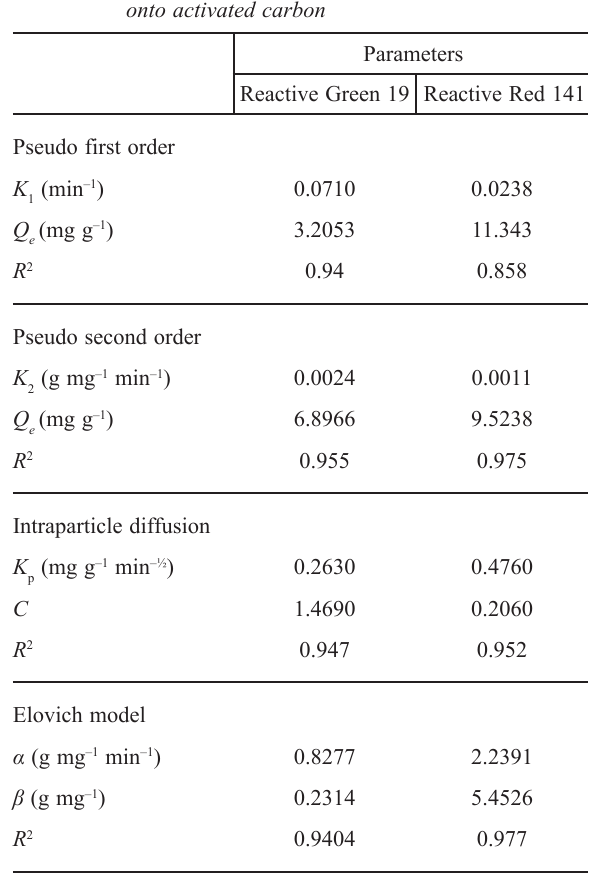
Table 5 – Kinetic parameters for adsorption of reactive dyes onto activated carbon Parameters